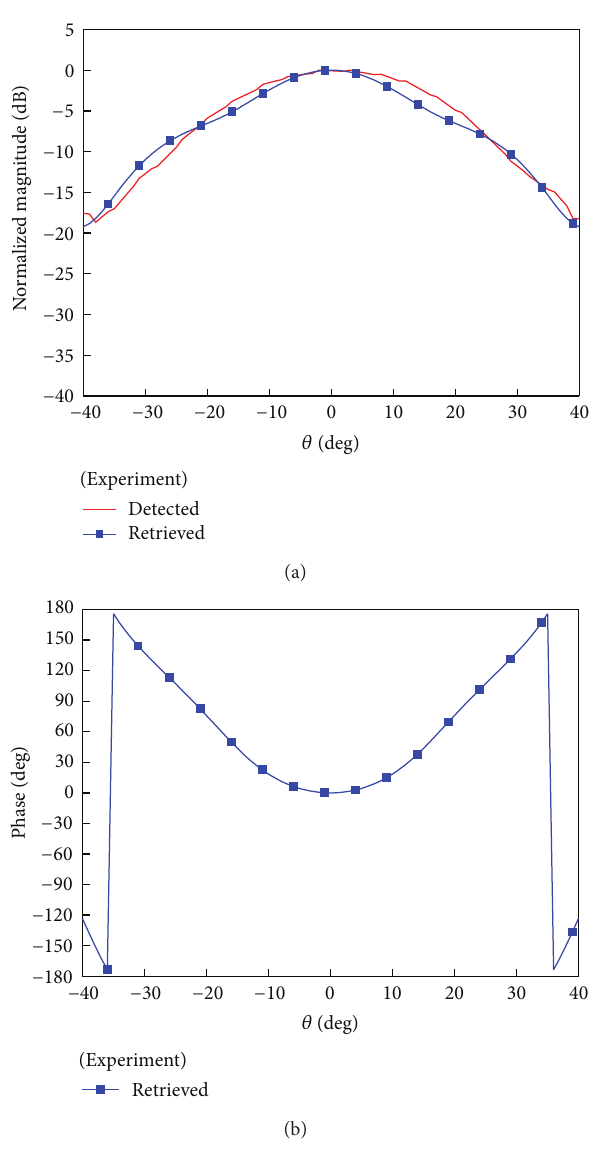
Figure 6: Fresnel field pattern from the experiment: (a) detected and retrieved magnitudes and the (b) retrieved phase.